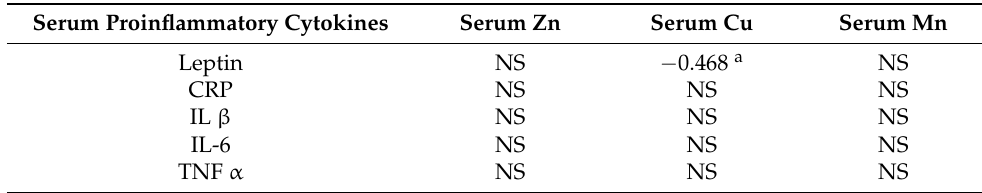
Table 5. Spearman’s rank correlation coefficient between serum levels of proinflammatory parameters and Zn, Cu and Mn. Serum Proinflammatory Cytokines Serum Zn Serum Cu Serum Mn Leptin NS − 0.468 a NS CRP NS NS NS IL β NS NS NS IL-6 NS NS NS TNF α